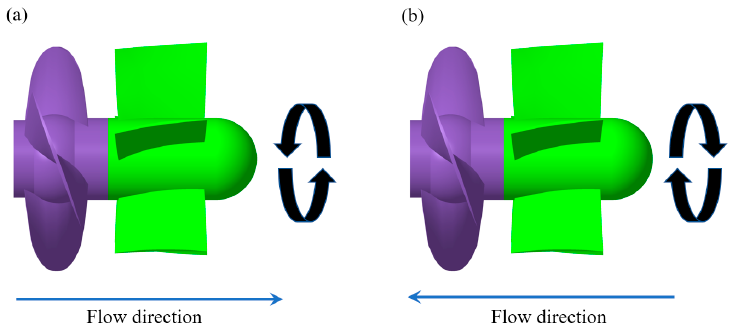
Figure 1. Impeller and guide vanes: ( a ) forward operation and ( b ) reverse operation.